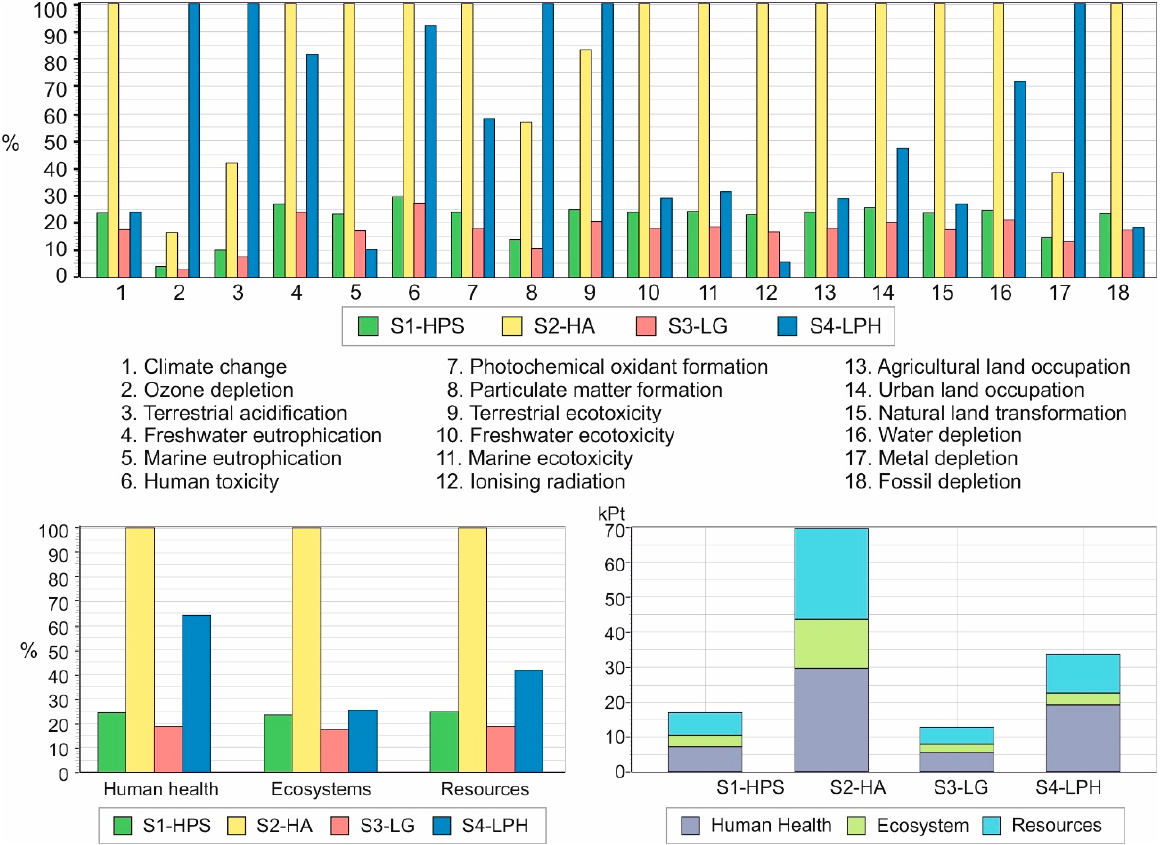
Figure 6. Comparative analysis of the environmental impact of the lighting system.